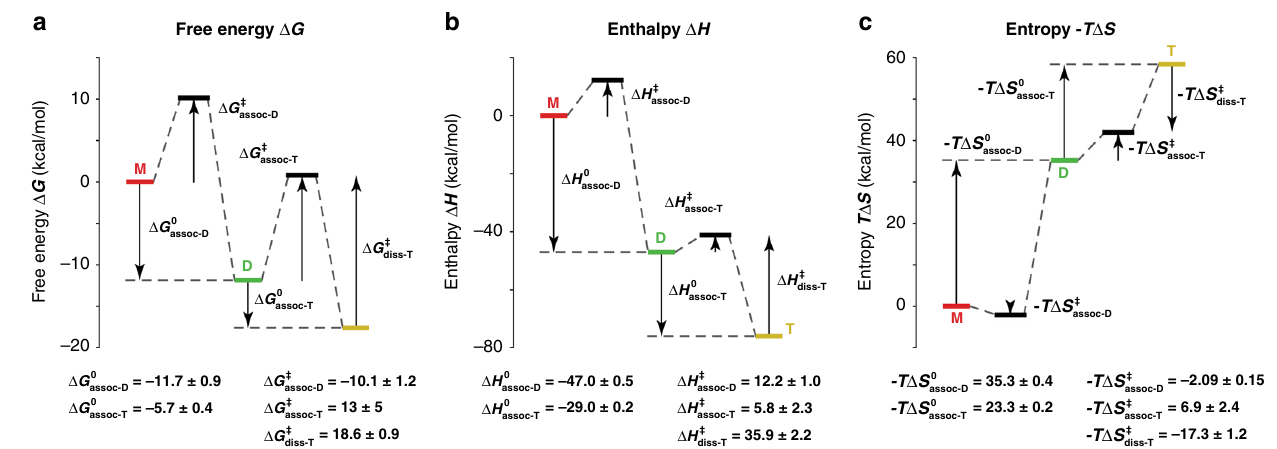
Fig. 5 Energy surfaces obtained from the combined equilibria and kinetics experiments. The experiments were monitored using mass spectrometry for the formation of the DNA duplex and triplex in 100 mM TMAA at pH 5.5: a Gibbs free energies, Δ G at 298K, b Enthalpies, Δ H , and c Entropies, – T. Δ S at 298 K. The y -axis corresponds to the calculated energies and the x -axis to the reaction coordinate. The values are reported in kcal/mol. The errors are the standard deviation obtained from the Van ’ t Hoff or Eyring analyses of Fig. 4.